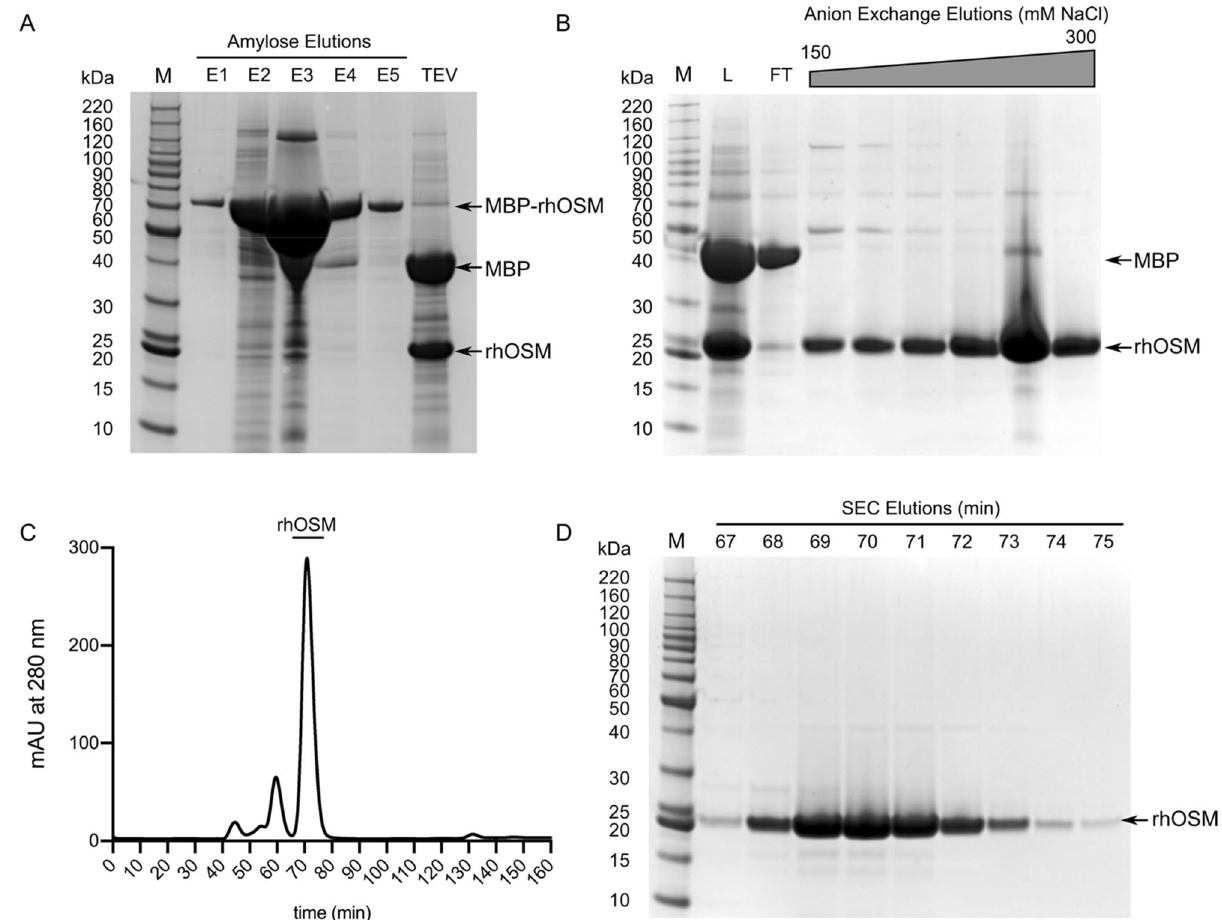
Figure 2. Expression and purification of rhOSM. ( A ) SDS-PAGE of amylose column purification of MBP-OSM, showing elutions E1-E5 and after cleavage with TEV. ( B ) SDS-PAGE of the load (L), flow-through (FT), and anion-exchange chromatography fractions. The fractions shown in gel were pooled and run over a size exclusion chromatography (SEC) column. ( C ) Chromatogram from SEC with rhOSM peak shown with bar. ( D ) SDS- PAGE of gel fractions from the SEC peak.